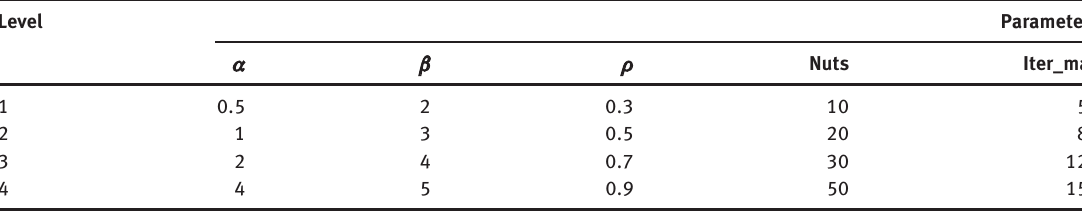
Table 2: Parameters and their Levels.